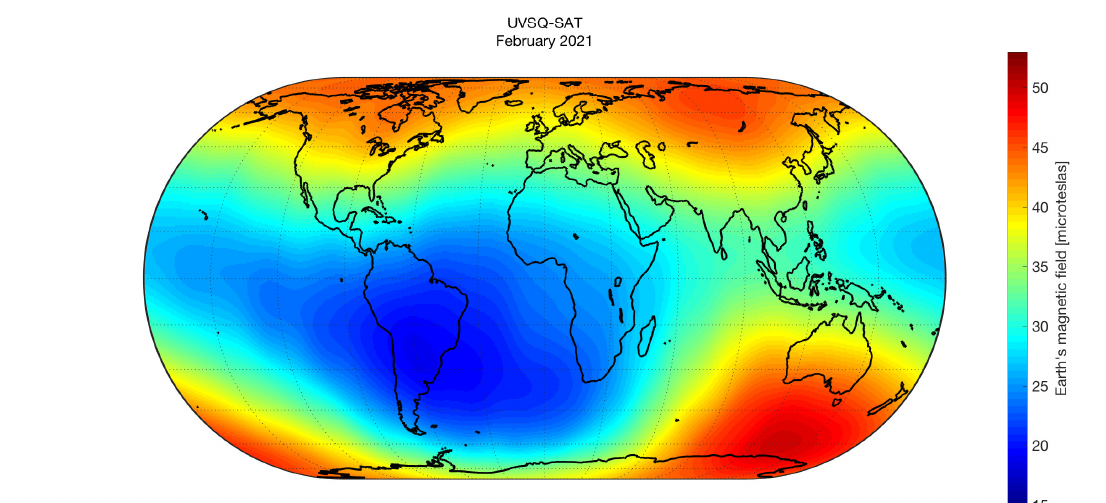
Figure 13. Earth’s magnetic field intensity measured by UVSQ-SAT instruments. The calibrations are being validated to consolidate the absolute measurement